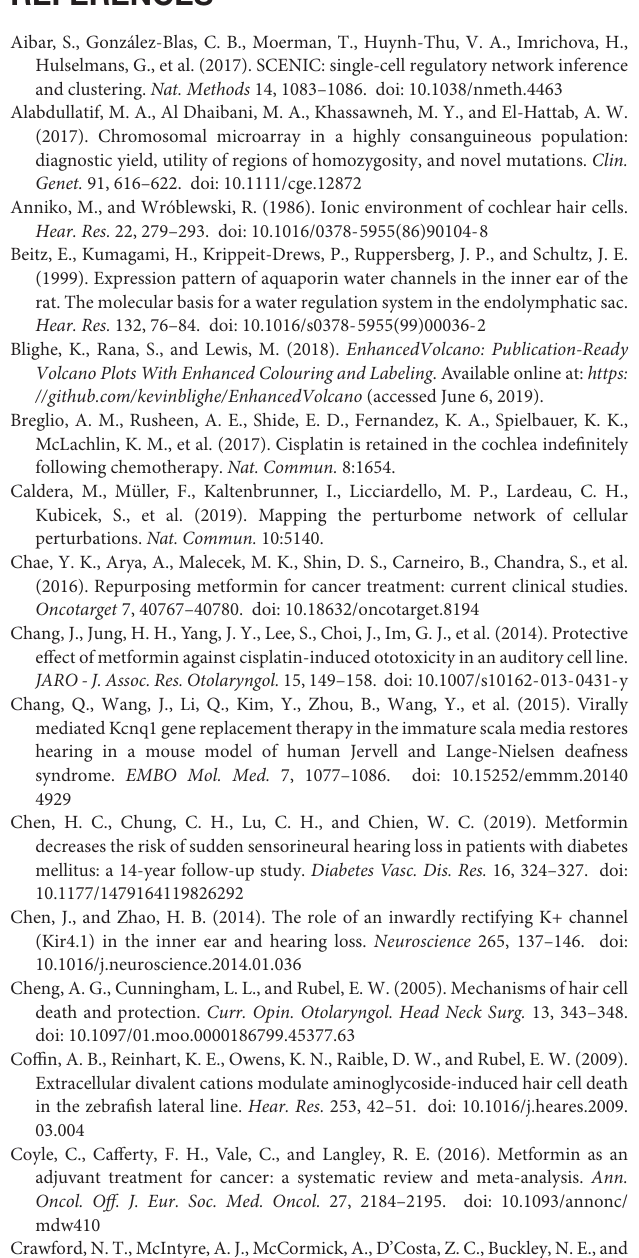
Supplementary Figure 5 | Protein expression of SPP1 is significantly reduced in cisplatin-treated SV as measured by immunofluorescence intensity analysis. Supplementary Figure 6 | Pharos druggable targets analysis combined with DE analysis identifies potential therapeutic gene targets and repurposable drugs for cisplatin-induced ototoxicity. (A) Illustration depicting the differentially expressed Tclin and Tchem target genes of the marginal cell specific regulon Klf10 . Genes are colored according to their Pharos gene family identification and interacting drugs and ligands are colored according to their drug-protein interaction. (B) The differentially expressed Tclin and Tchem target genes of the intermediate cell specific regulon Tbx2 .